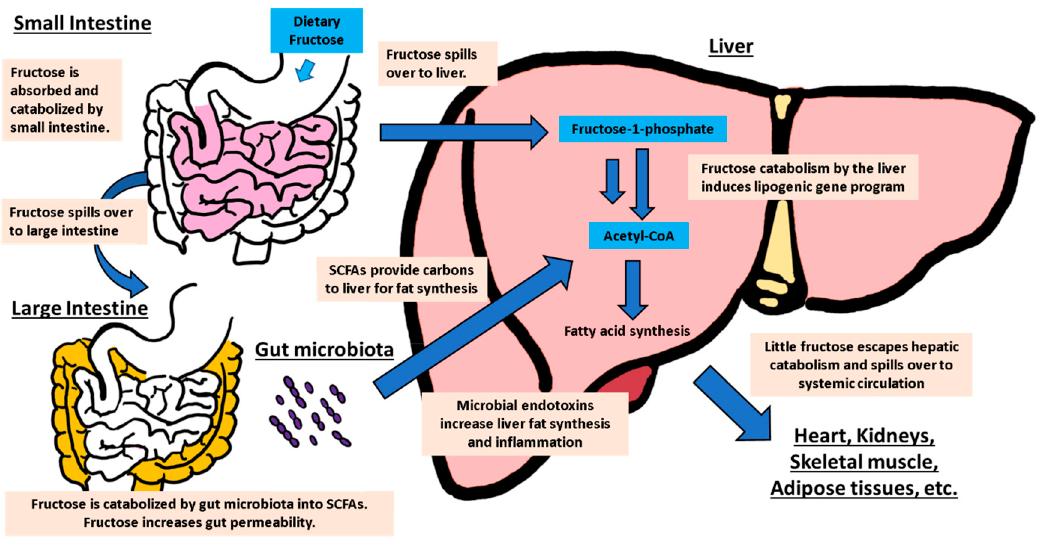
Figure 2. Contribution of whole-body fructose metabolism to non-alcoholic fatty liver disease (NAFLD). Physiological doses of dietary fructose are mostly catabolized by the small intestine. However, high-doses or rapid consumption (e.g., liquid-form) results in fructose spillover to both the liver and the large intestine. In the liver, uncontrolled fructose catabolism induces hepatic lipogenesis. In the large intestine, fructose feeds gut microbiota, generating short-chain fatty acids (SCFAs) as a carbon source of hepatic lipogenesis. Fructose also increases the gut permeability, enhancing hepatic inflammation via endotoxins. Most dietary fructose is cleared by the intestine and the liver and very little reaches other organs.